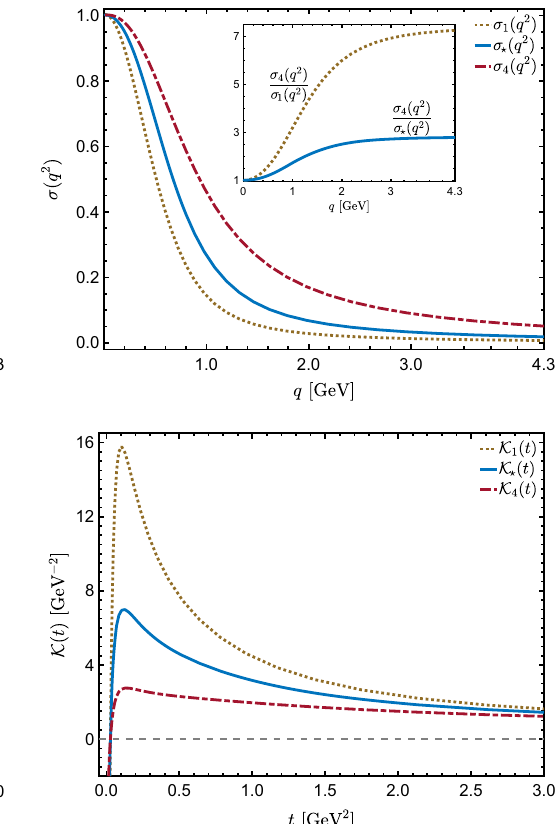
( q 2 ) , R (cid:20) ( q 2 ) , and 1 ( t ) , 1